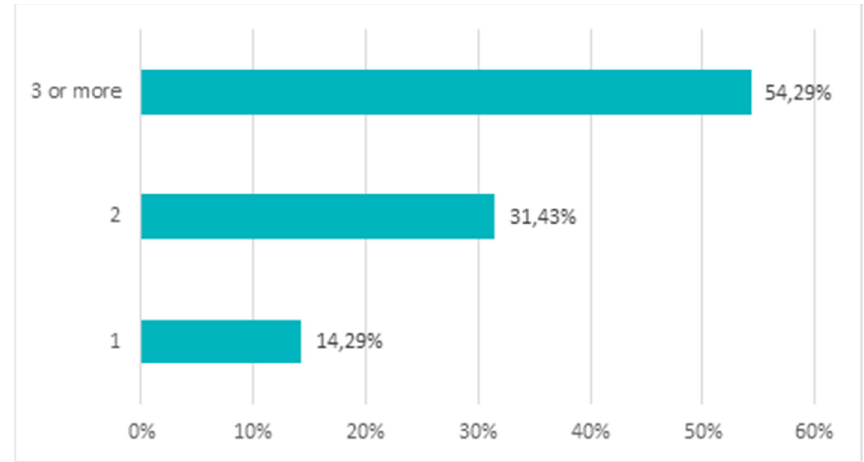
Figure 10. Total family members per household.